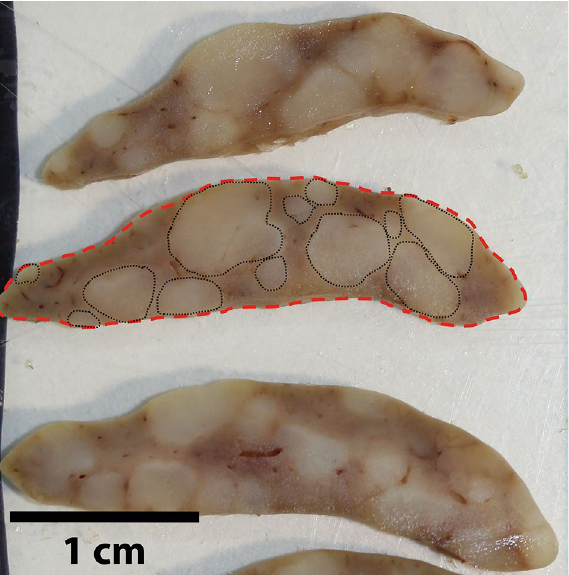
Figure 5. Measurement of absolute tumour surface area (ATSA) (encircled by discontinuous black lines) and absolute liver surface area (ALSA) (shaded green and encircled by a discontinuous red line) in each slice using ImageJ, version 1.52p for windows, U.S. National Institutes of Health, Bethesda,